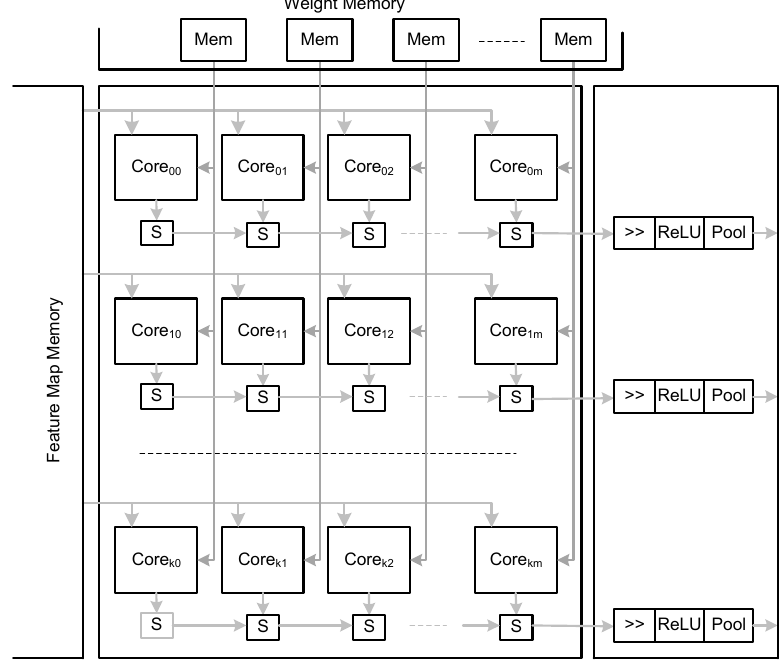
Figure 2. Architecture of the PE cluster for convolutional